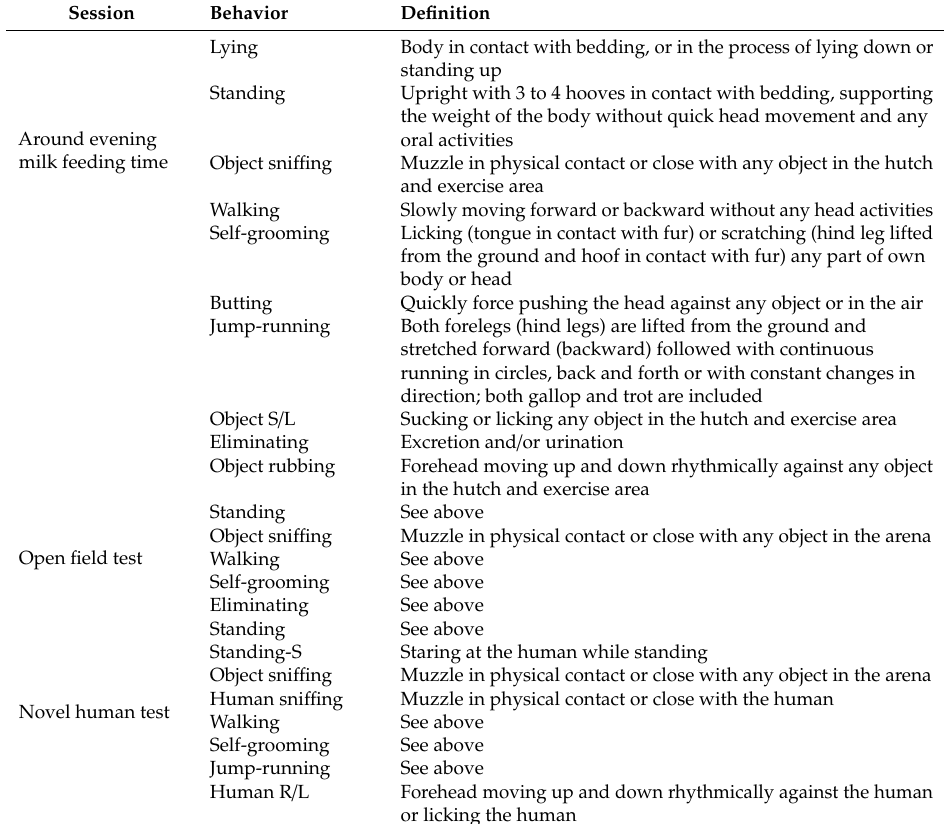
Table 1. The ethogram of behavior observed around evening milk feeding and during open field test and novel human test of Holstein female calves (partially based on Duve and Jensen,